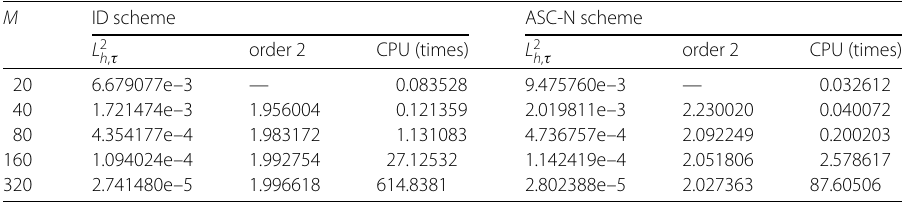
Table 3 The numerical errors and convergence orders in spatial direction ( α = 0.5, τ = h 2 )